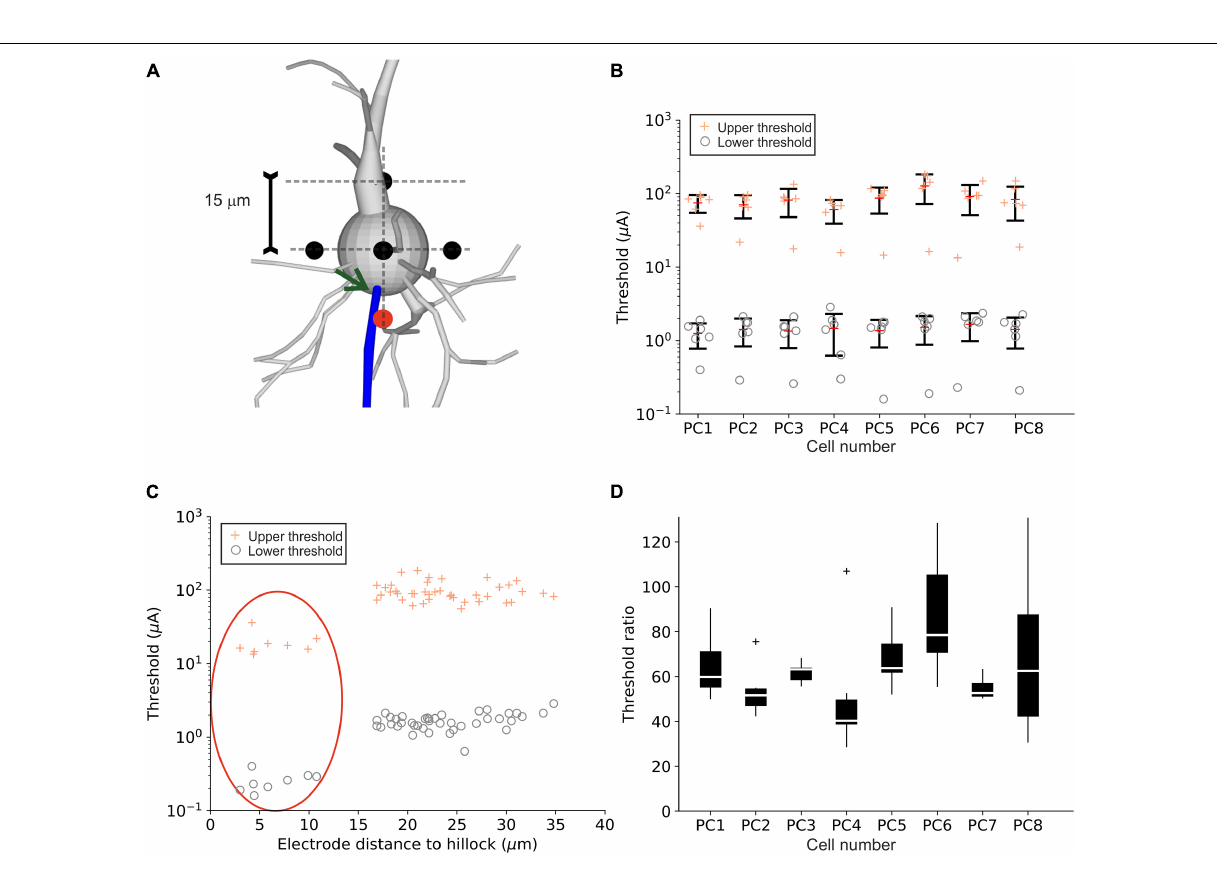
FIGURE 6 | Upper and lower threshold for different point source locations close to the PC soma. (A) Six electrode positions (black and red circles) in a distance of 15 µ m to the soma center were investigated for the eight PC model neurons. The red circle indicates the electrode positions closest to the hillock (indicated by arrow). (B) LTs (“o”) and UTs (“+”) are shown for individual cells. (C) LTs (“o”) and UTs (“+”) plotted as a function of electrode distance to the hillock. Points within the red ellipse correspond to the red electrode location in panel (A) . (D) Threshold ratios for all eight PCs for all electrode